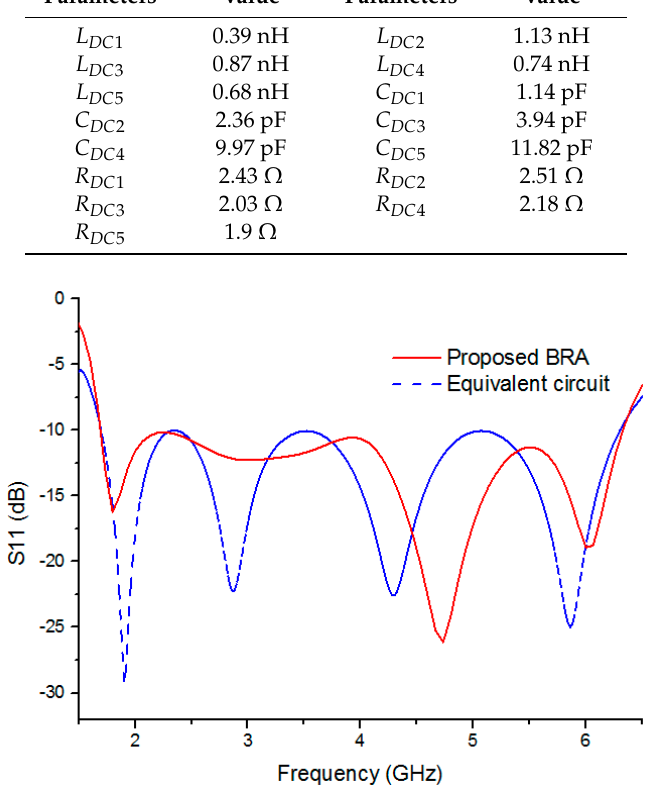
Figure 5. Comparison of the S11 between the BRA and the equivalent circuit.